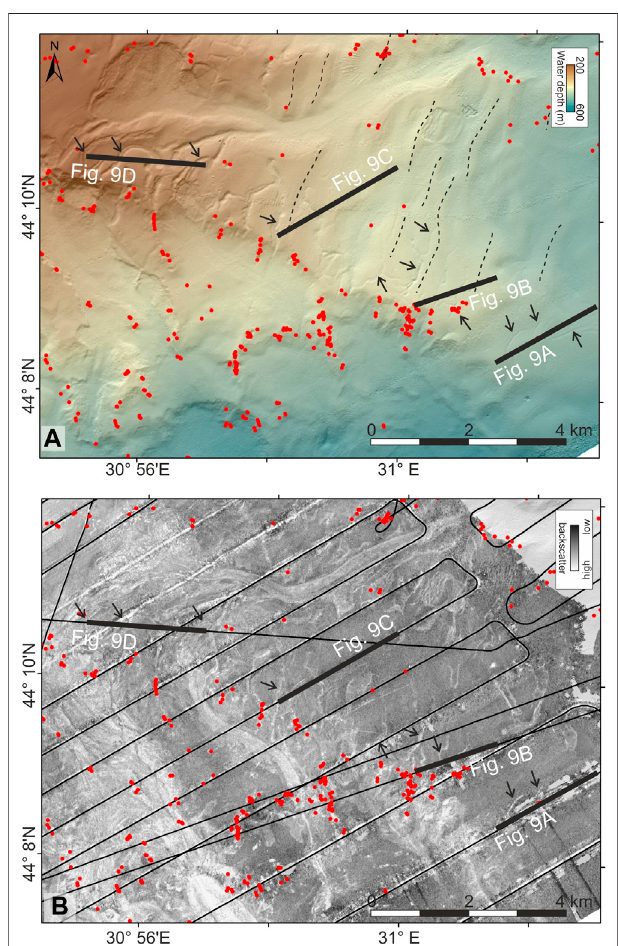
FIGURE 8 | Example of the sea fl oor morphology in a region with old sediment-wave crests (now draped) creating sub-sea fl oor pathways for upwardmigratinggas(reddotsareseepsites). (A) multibeambathymetryand (B) sea fl oorbackscatter.Dottedlinesin (A) aresomeexamplesoftheold wave-crest outline. Solid black lines are sections of sub-bottom pro fi ler data shown in Figure 10 .